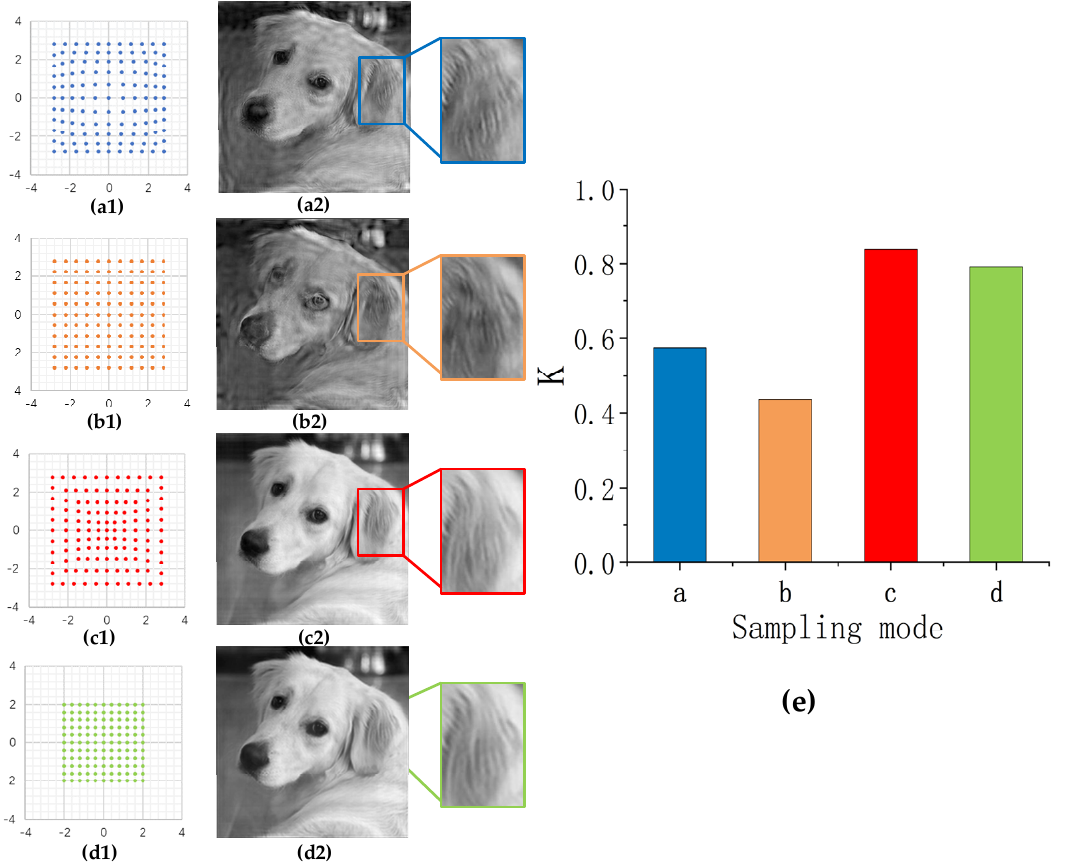
Figure 4. Different sampling modes, reconstructed images and analysis. ( a1 , c1 ) are non-uniform sampling, ( a1 ) has a low overlap rate in the central area and a high overlap rate away from the center. ( c1 ) is the opposite of ( a1 ). ( b1 , d1 ) are uniform sampling modes. ( a2 − d2 ) are the corresponding image reconstruction results and partial enlarged images. ( e ) The structural similarity values K corresponding to different reconstructed images.